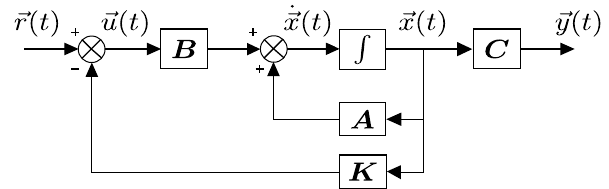
Figure 6. Full feedback states block